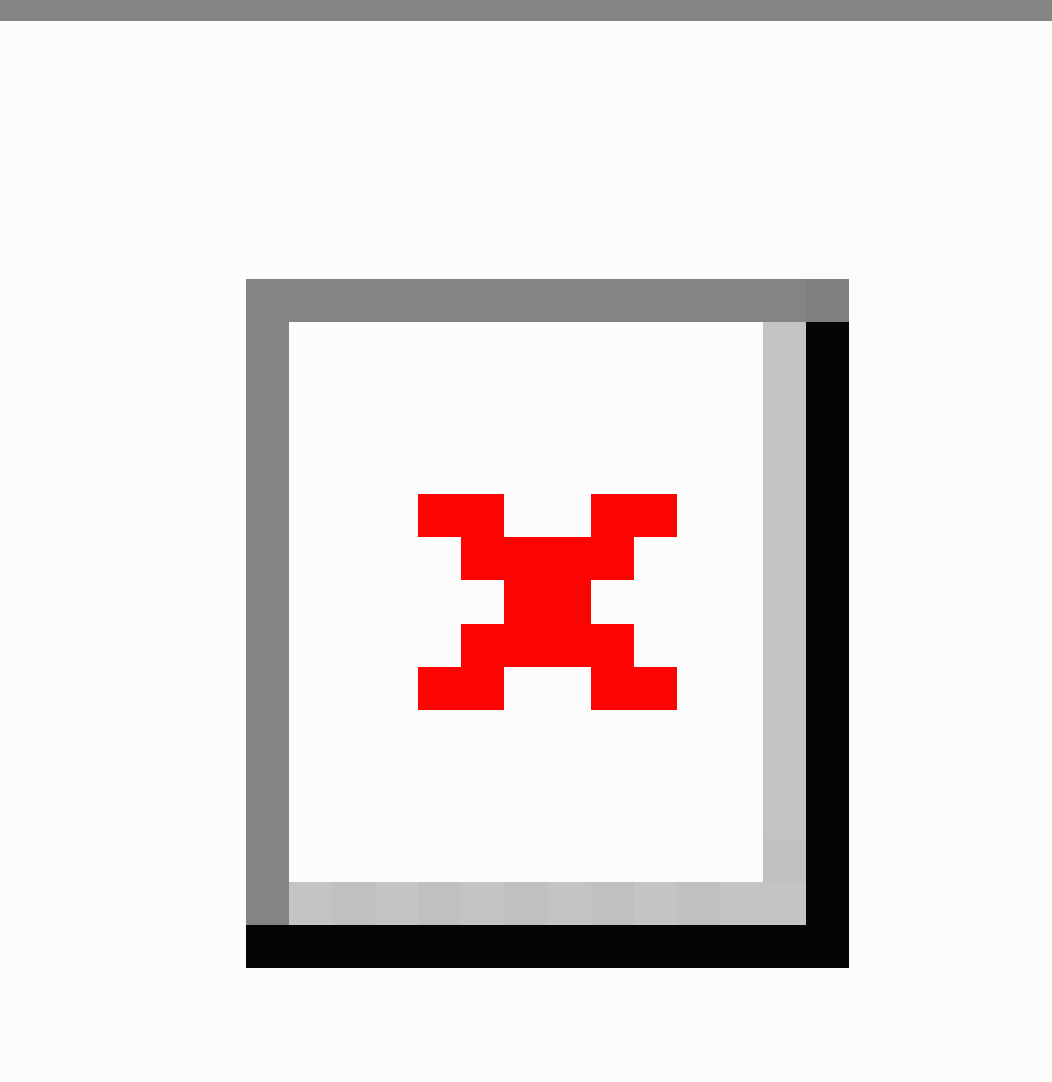
Figure 2. Performance of the convolutional neural network in the identification and classification of rosacea and other skin diseases. A. Confusion matrix showing the accuracy and precision of 0.914 and 0.898, respectively; B. Receiver operating characteristic curve showing that the area under the receiver operating characteristic curve reached 0.972; C. Performance of the convolutional neural network in the classification of subtypes of